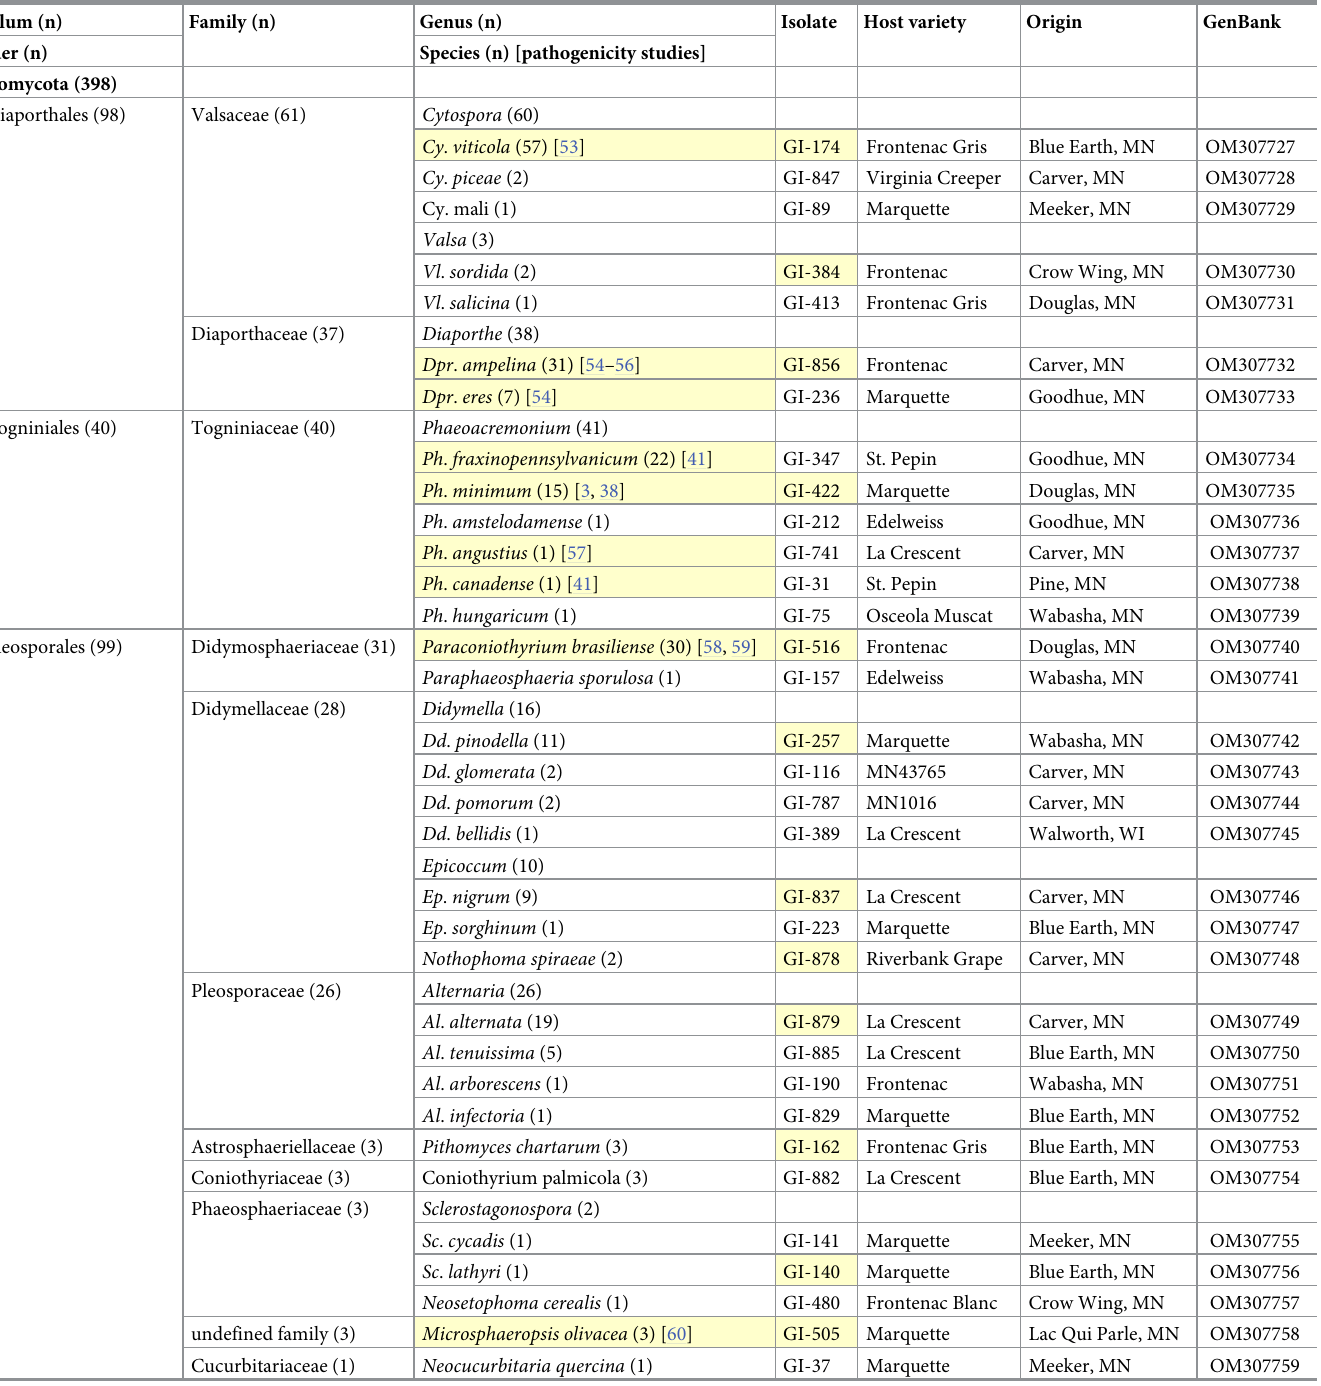
Table 3. Taxonomy, isolation frequency, and pathogenicity of fungi identified by ITS with greater than 97% homology